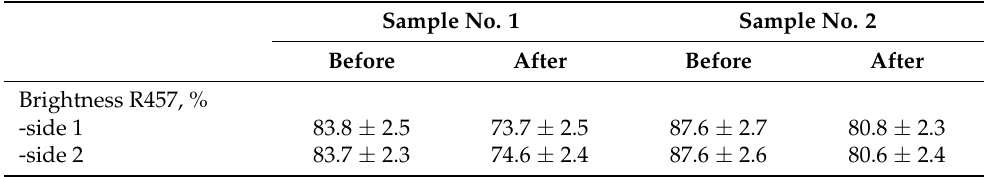
Table 5. Brightness values of paper sample nos. 1 and 2 before and after